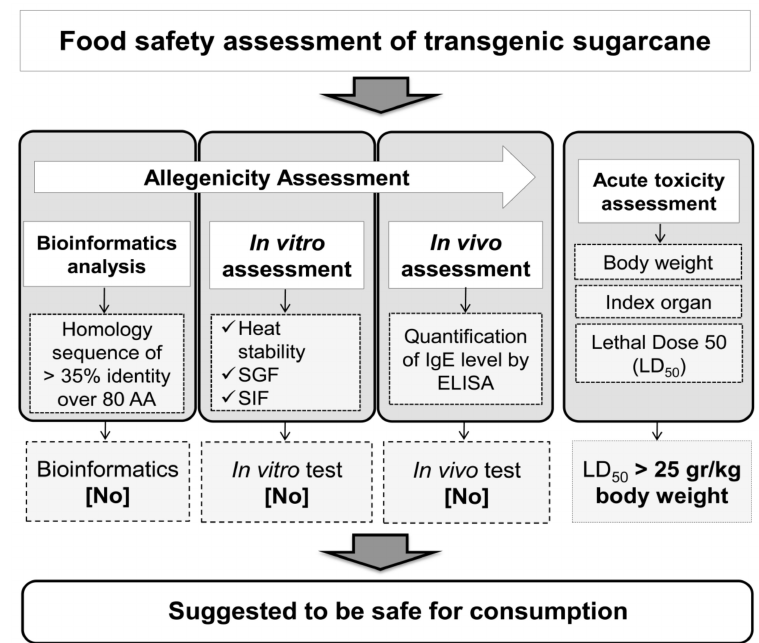
Figure 5. Overview and framework of food safety risk analysis in transgenic sugarcane. The food safety assessment of transgenic sugarcane consists of several steps including allergenicity and toxicity tests. The total protein was utilized for in vitro assessment, while animal models were used for in vivo assessment using sugarcane juice to compare the effects of administration of transgenic and non-transgenic